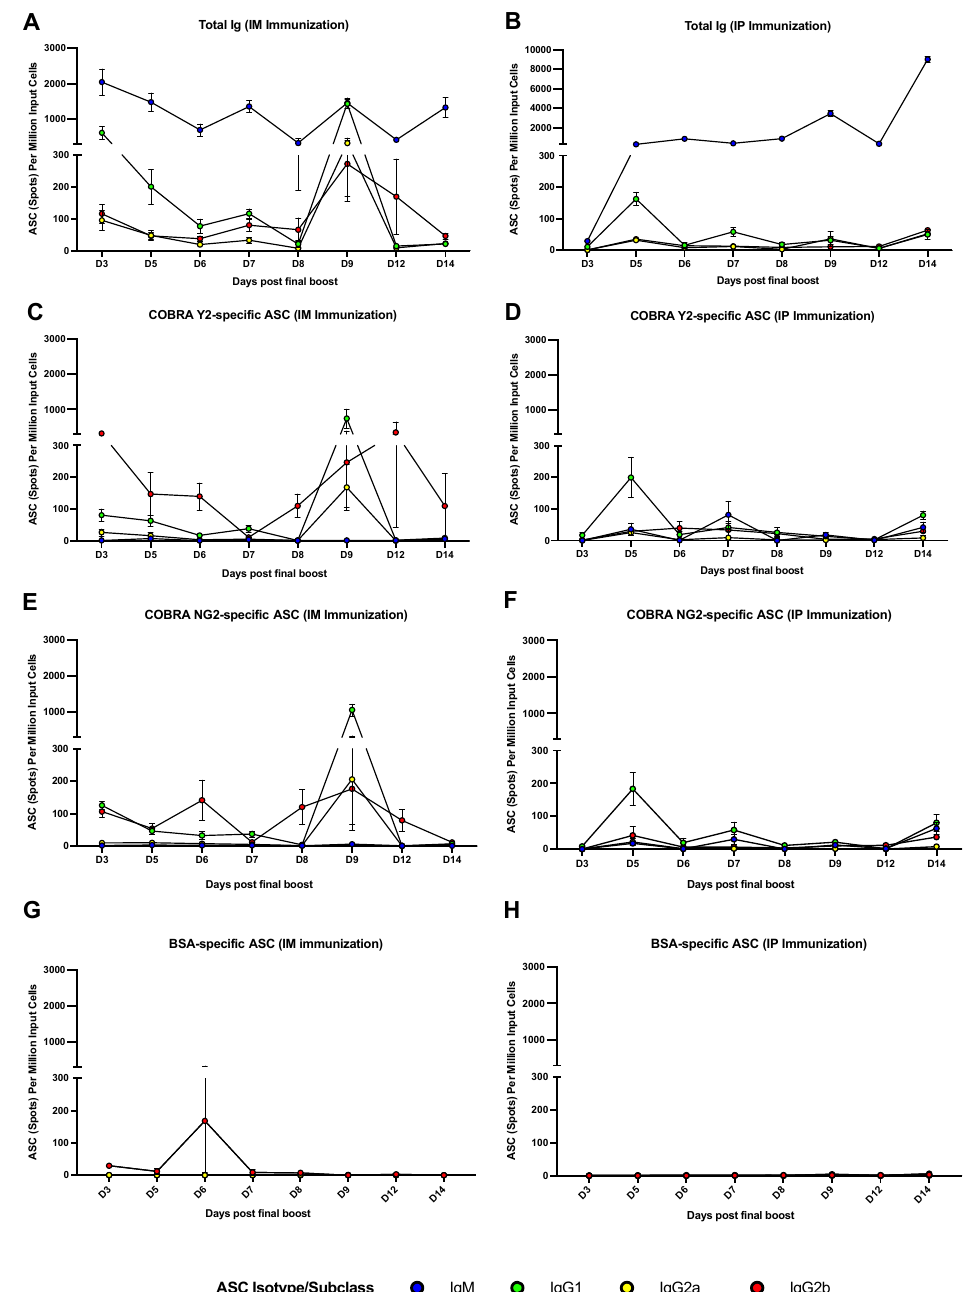
Figure 4. Enumeration of total ( A , B ), COBRA Y2 and NG2 Ag-specific ASCs ( C – F ) from splenocytes collected at different time points following the final boost of mice that were IP- or IM-immunized with the combination of COBRA Y2 and NG2 rHAs. BSA was used as an irrelevant antigen for ASC background reactivity purposes ( G , H ). Shown results are expressed as absolute mean values plus SEM (error bars) using the different mouse group splenocytes. The limit of detection of the assay is 1/100,000 cells (spots). A synopsis of the statistical analysis comparing the magnitude of the IgM and IgG1, IgG2a, IgG2b antibody subclass ASCs across the different time points is reported in the Supplementary Materials.